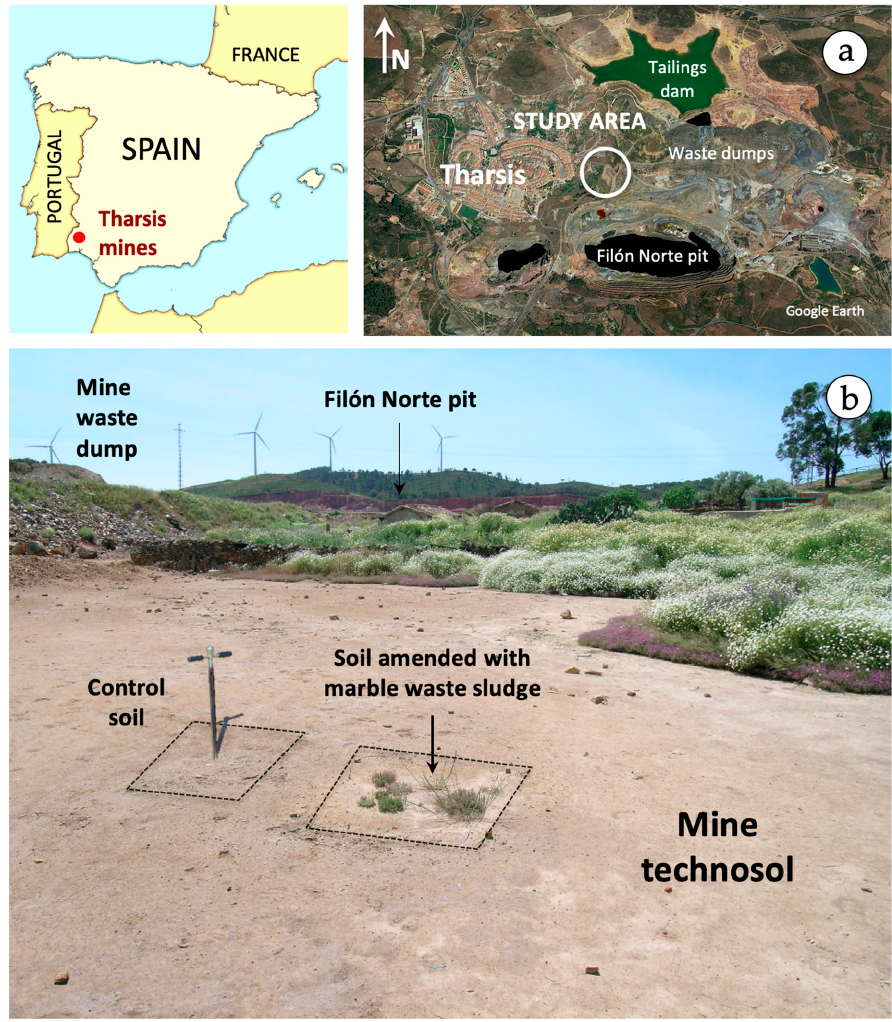
Figure 1. Figure 1. Location map of the study area showing a satellite view of the mining area of Tharsis ( a ), and a field picture of the field experimental site ( b